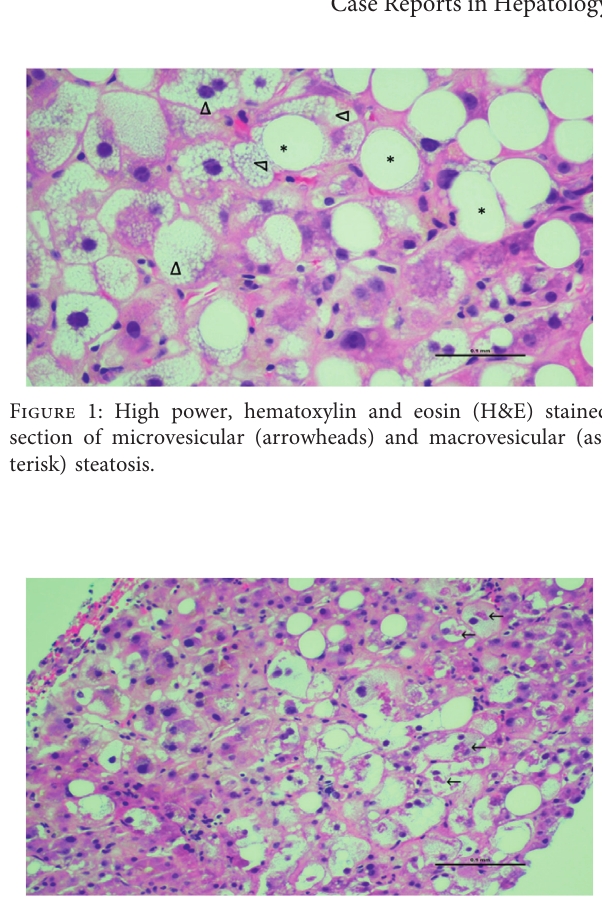
Figure 2: High power, hematoxylin and eosin (H&E) stained section showing cytoplasmic ballooning of hepatocytes with the presence of Mallory’s Hyaline